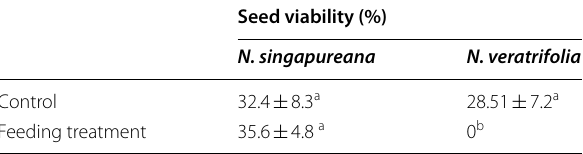
Data are mean SD. Means within a column followed by the same letter are not ± significantly different at P